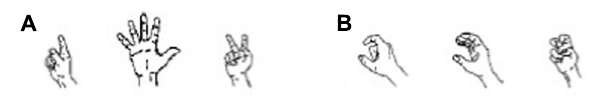
FIGURE 4 | Examples of handshapes with (A) straight fingers and (B) with curved